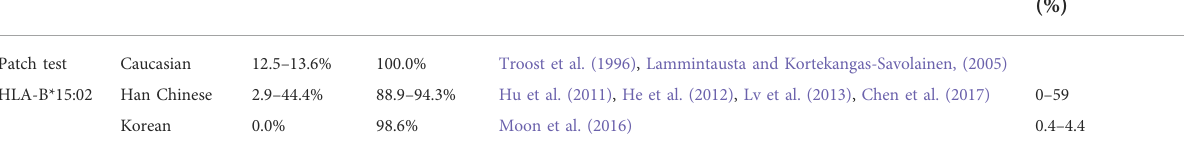
TABLE 4 Sensitivity and speci fi city of patch tests and HLA tests for oxcarbazepine-induced